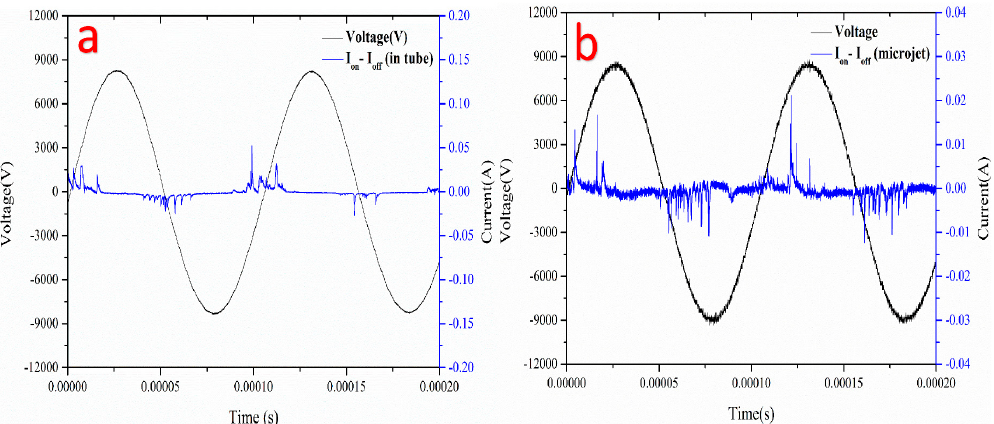
Figure 4. ( a , b ) Measured waveforms of applied voltage and discharge current of dielectric barrier discharge plasma in the glass tube and single plasma microjet, respectively. Experiment conditions: helium/oxygen mixed flow rate of 700 sccm/7 sccm, the frequency was around 11 kHz.